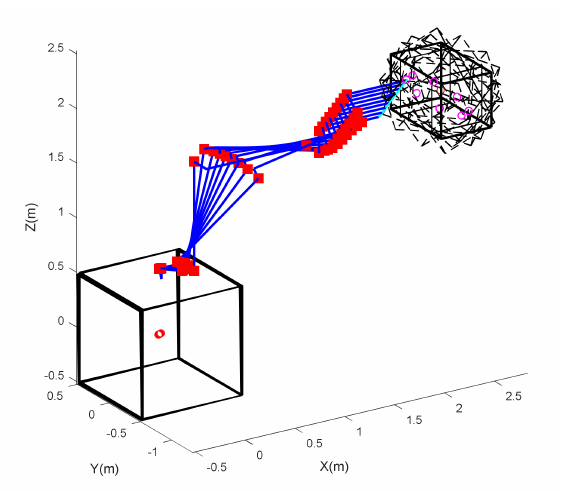
Figure 13. Capture process of 7-dof space robot without optimization.